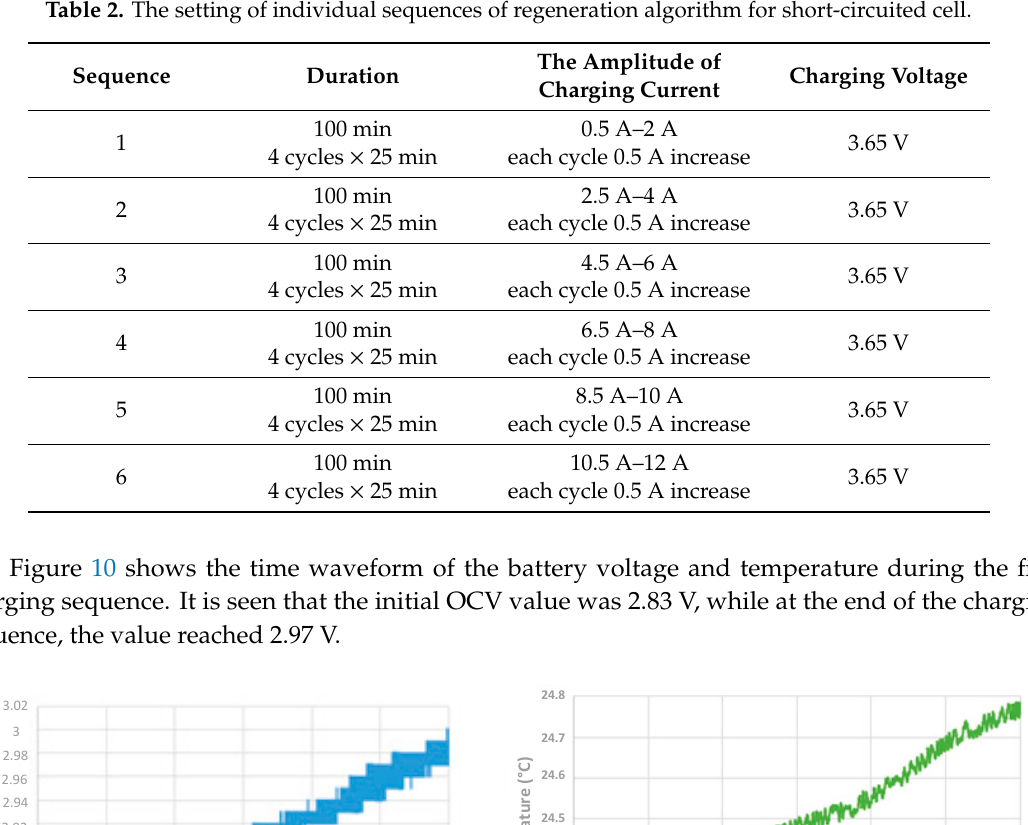
Figure 9. Graphical interpretation of proposed regeneration procedure for short-circuited cells including resting periods of DUT.